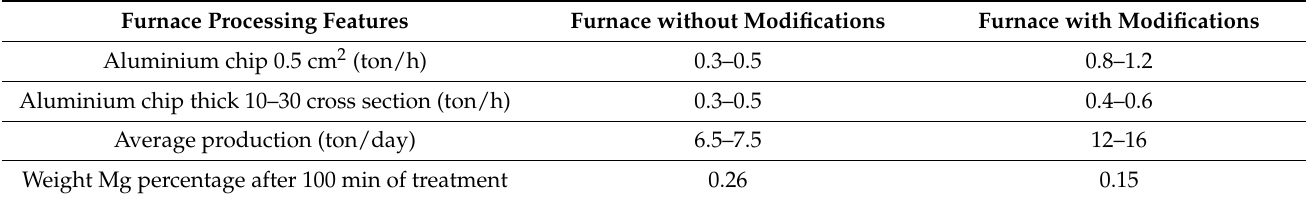
Table 4. Production results of the furnace before and after